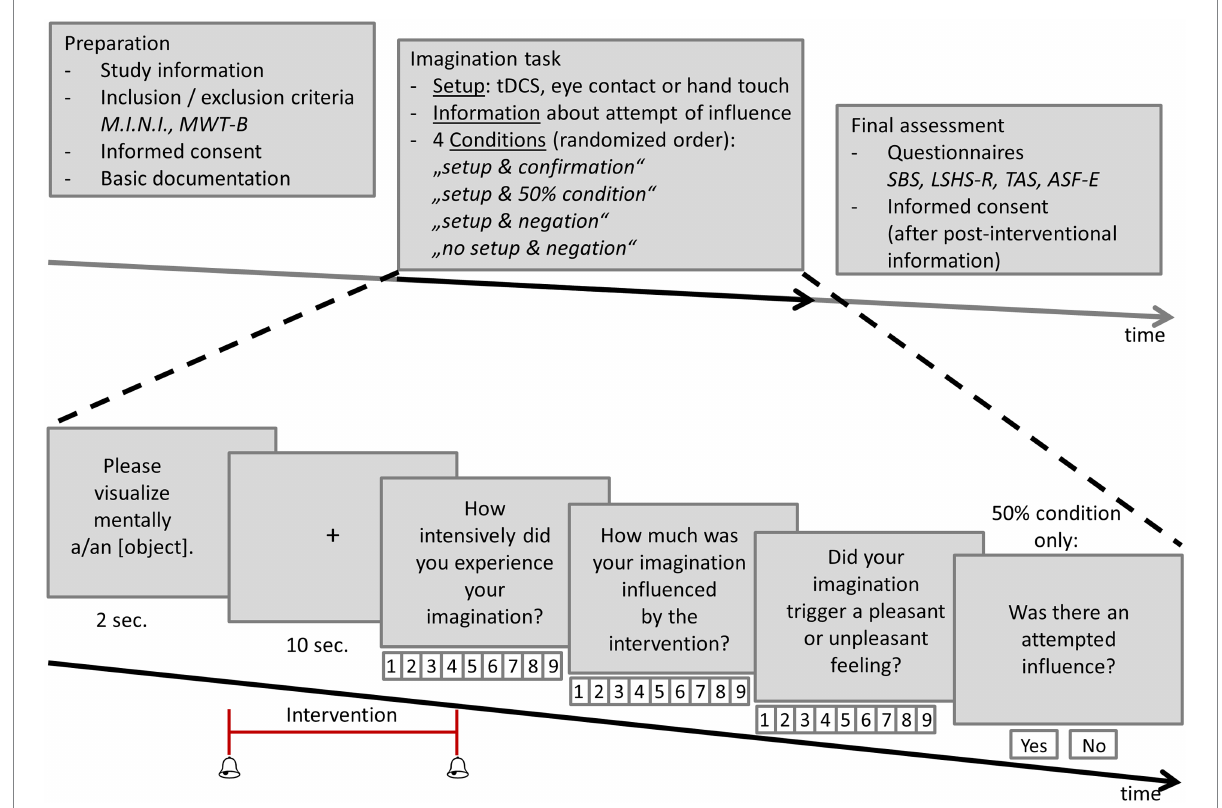
FIGURE 1 Experimental design. Upper row: Following study preparation, the physical setup was prepared (tDCS, eye contact, or hand touch) and participants were informed whether external influence was attempted in the next trial block (confirmation/negation/50% condition). Following the completion of the imagination task, the final assessments were carried out (including a post-interventional informed consent). Lower row: The imagination task started with the request to mentally visualize an object for 10 s. The beginning and the end of the imagination period was signaled by a short sound. During this imagination the intervention was carried out according to the respective, randomized condition comprising setup (tDCS, eye contact, or hand touch) and information on whether external influence was attempted (confirmation/negation/50% condition). Afterwards the participants were asked to rate the intensity of their imagination, the extent of perceived external influence and the emotional valence of their imagination on a 9-point Likert scale ranging from 1 = very low/unpleasant to 9 = very high/pleasant. In the setup and 50% condition an additional question was asked concerning the assumption of whether external influence was attempted in the last